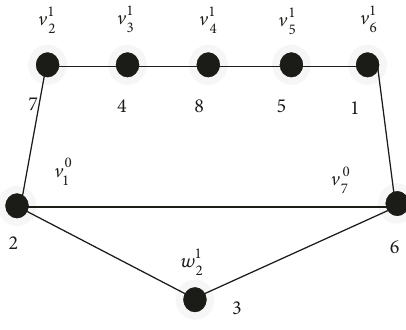
Figure 4: Bijective function 𝑓 3 (𝑥) .